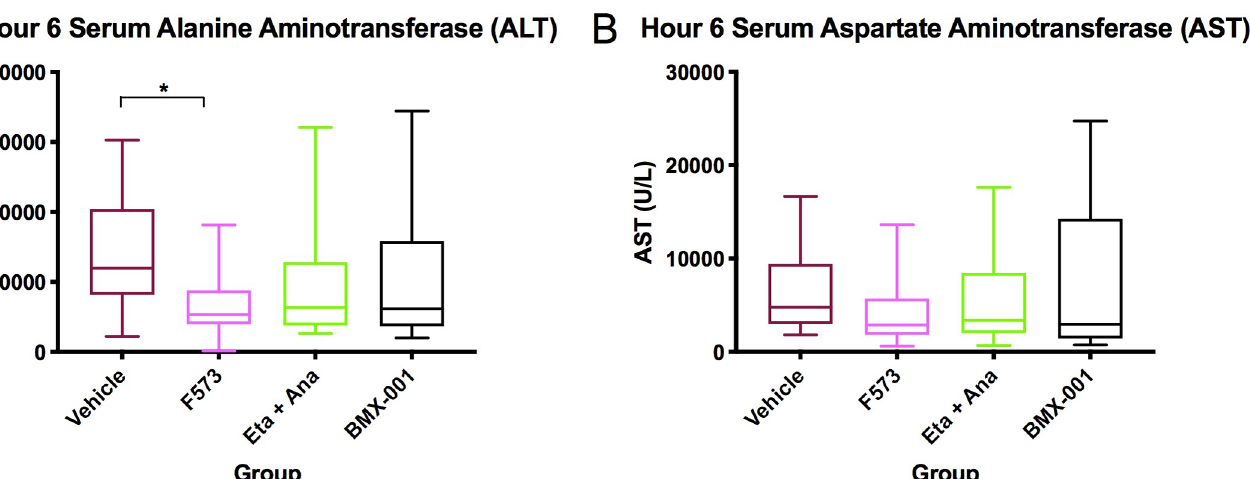
PLOS ONE | https://doi.org/10.1371/journal.pone.0224567 November26,